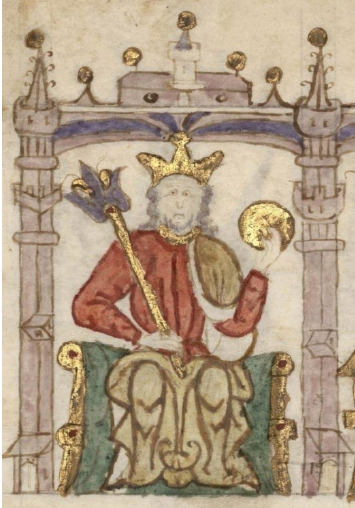
Figure 7. D. Sancho II—Compendio de crónicas de reyes (Biblioteca Nacional de España), 1312–1325.